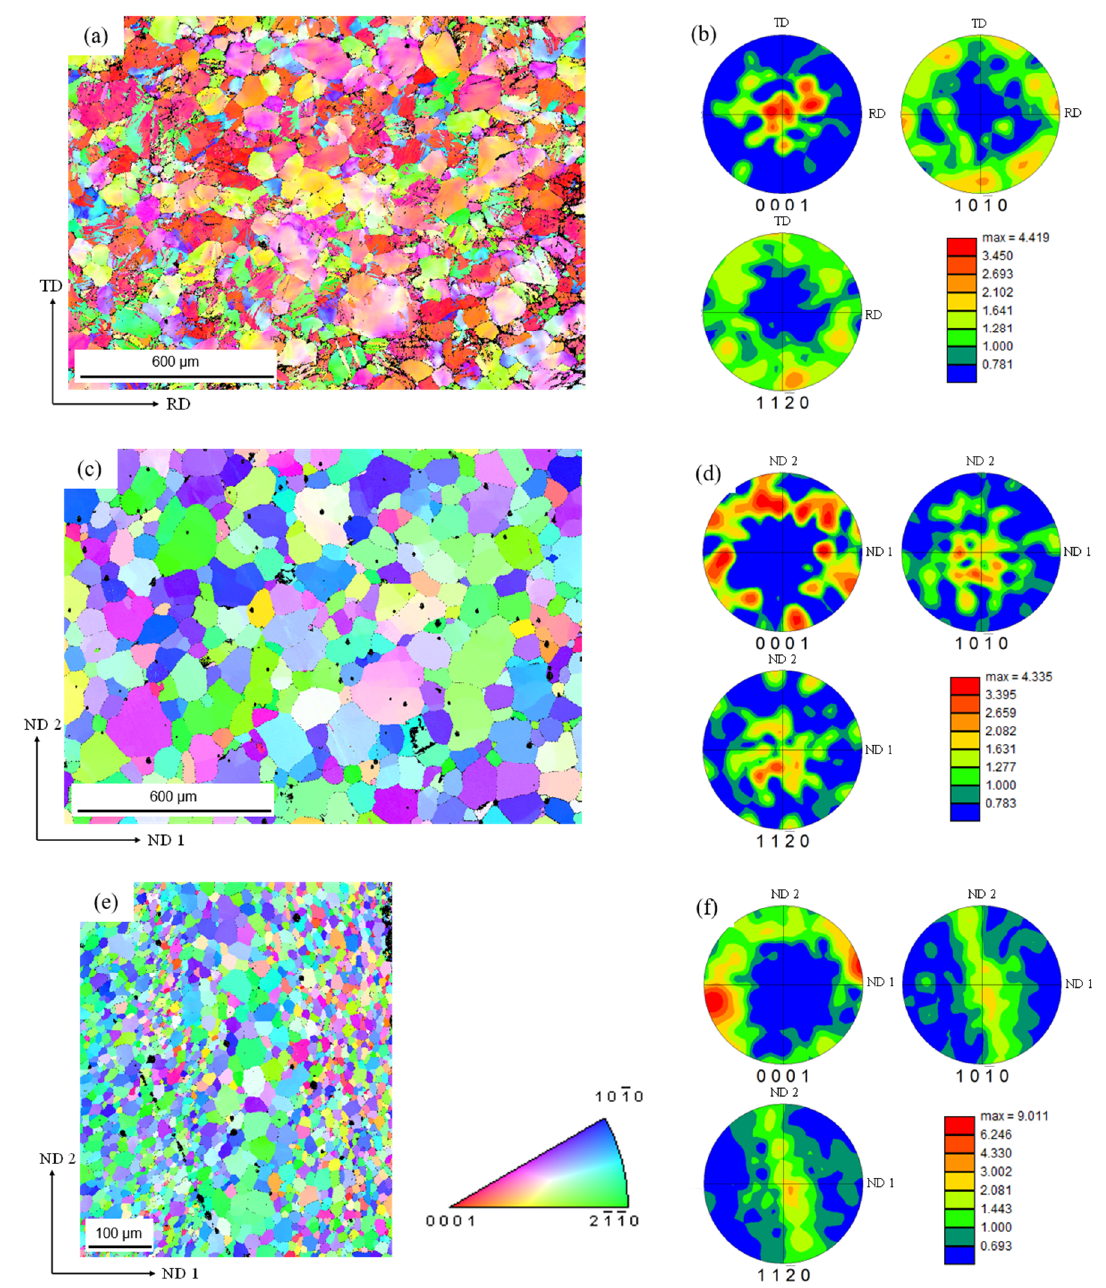
Figure 9. EBSD images showing orientation maps for ( a ) the BM in the TD–RD plane, rod cross- section (ND1-ND2 plane)—( c ) the core, and ( e ) the edge; ( b , d , f ) represent pole figures for the BM, rod core, and rod edge, respectively.